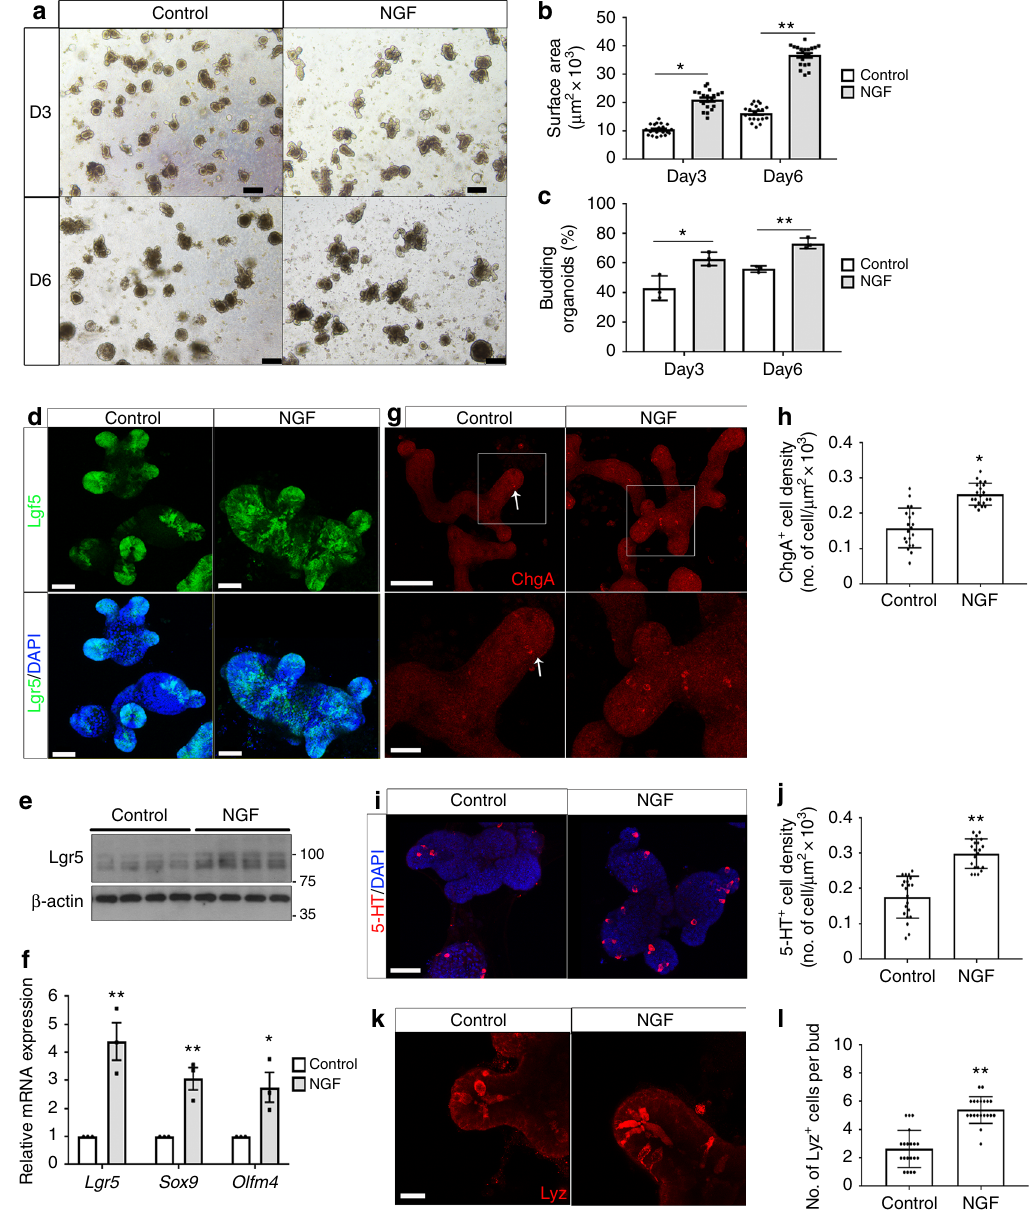
Fig. 3 NGF enhances the functions of intestinal stem cells in organoid cultures. a Representative images show the intestinal organoids cultured with or without recombinant NGF at day 3 (D3) and day 6 (D6) in culture (scale bars: 100 μ m). b The size of organoids cultured with or without recombinant NGF (* p < 0.05, ** p < 0.01; n = 20 organoids per group, two-tailed t test). c The ef fi ciency in organoid formation under the culture condition with/without recombinant NGF (* p < 0.05, ** p < 0.01; n = 3 per group, two-tailed t test). d Whole-mount confocal imaging for the EGFP expression (green) in Lgr5- EGFP + organoids cultured with/without NGF. Nuclei were counterstained by DAPI (blue) (scale bars: 50 μ m for panels a , b ; 100 μ m for panels c , d ). e Western blotting analyses for Lgr5 expression in organoids with/without NGF. f qPCR analyses for the expression of stem cell marker genes ( Lgr5 , Sox9 , and Olfm4 ) in organoids cultured with/without NGF (* p < 0.05, ** p < 0.01; n = 3, two-tailed t test). g The enteroendocrine cells in organoids cultured with/ without NGF were stained with chromogranin A (Chga) (red) and visualized by whole-mount confocal imaging. The lower panels show the higher magni fi cation of boxed areas in the upper panels. The density for Chga + in organoids was quanti fi ed in h . (* p < 0.05; n = 20 organoids, two-tailed t test) (scale bars: 50 μ m for upper panels, 20 μ m for lower panels). i Whole-mount immuno fl uorescent co-staining for serotonin/5-HT (red) and DAPI (blue) in organoids cultured with/without NGF (scale bars: 50 μ m). j Quanti fi cation for the density of 5-HT + EC cells in organoids cultured with/without NGF (** p < 0.01; n = 20 organoids, two-tailed t test). k Confocal imaging shows immunostaining for lysozyme (red) in organoids cultured with/without NGF (scale bars: 20 μ m). l The Paneth cell frequency per bed was presented by the average number of lyz + cells per bud in organoids (** p < 0.01; n = 20 organoids, two-tailed t test). All data represent the mean ±